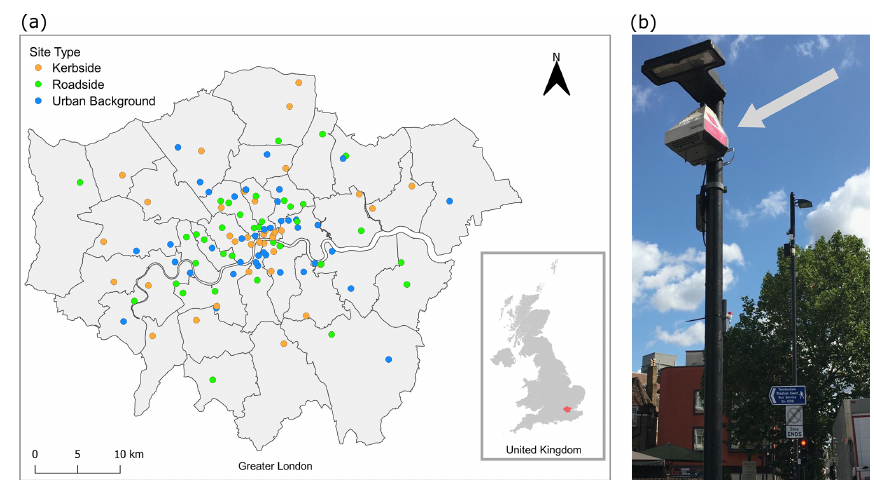
Figure 1. (a) BL network locations across Greater London. (b) Picture of BL AQMesh unit (indicated by arrow) installed at Kew Road,